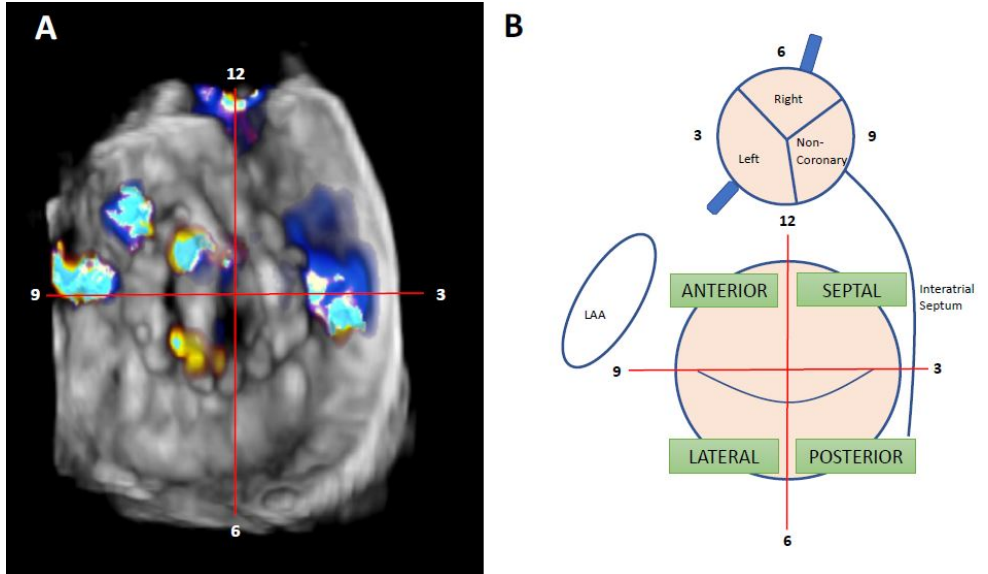
Figure 4. Localization of mitral PVL. ( A ): Clockwise format. Surgeon’s view. TEE from the same patients; we can see the presence of two anterolateral leaks, at 9 and 10 h, and one septal leak at 3 h. ( B ): mitral and aortic drawing of clockwise format and interactions between different hearts structures—adapted from reference [2].